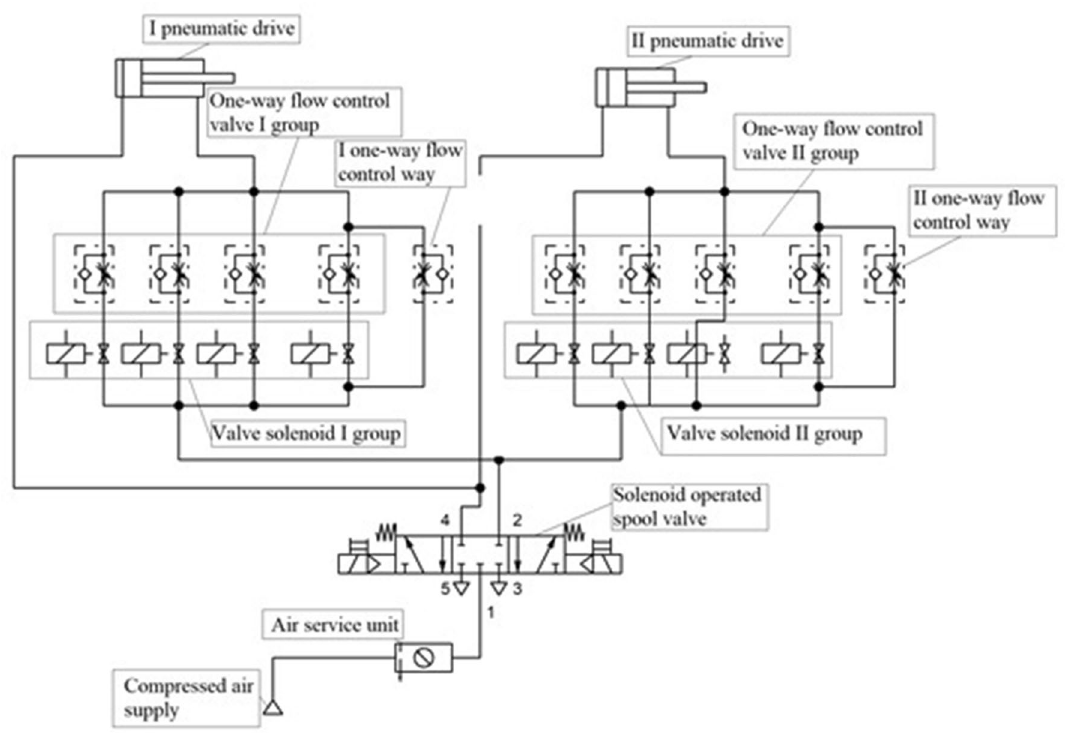
Figure 1. Schematic representation of the pneumatic control system used to steer the author’s patented rehabilitation device [FluidSIM-P 5.0, Festo: https:// www. festo- didac tic. com/ int- en/ servi ces/ print ed- media/ manua ls/ fluid sim-5- user- guide. htm? fbid= aW50L mVuLj U1Ny4 xNy4z Mi44M jguNz